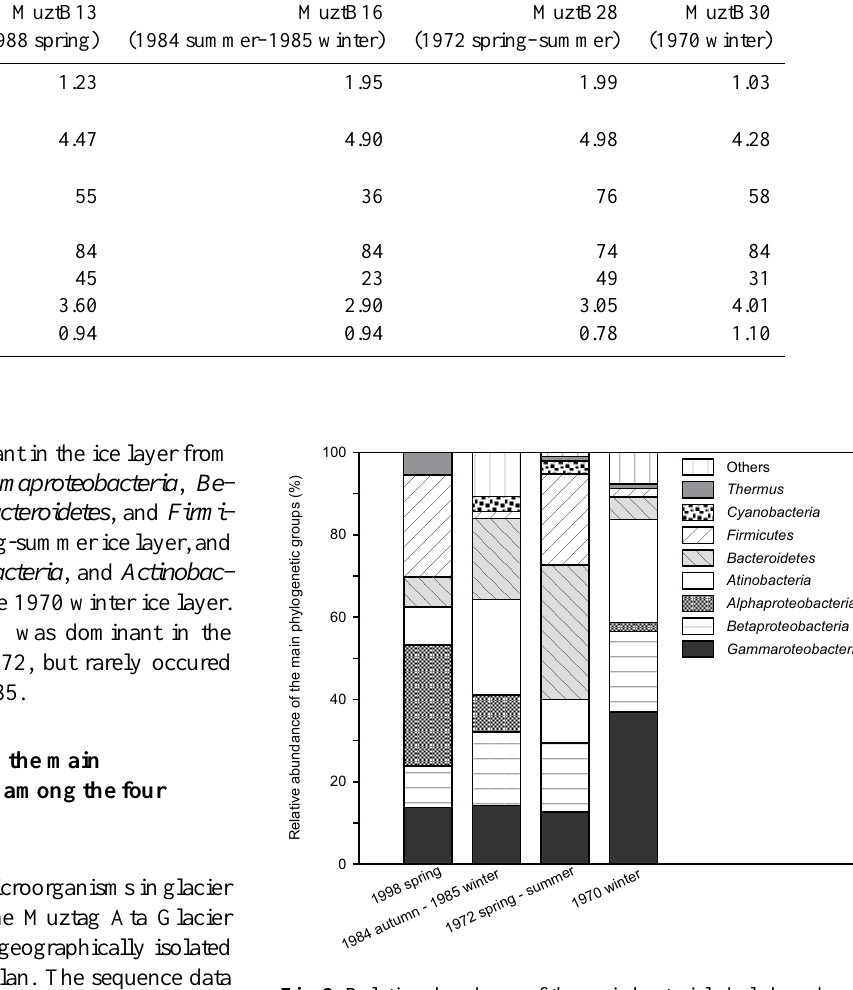
Table 1. Biomass and diversity of dominant bacteria in the Muztag Ata Glacier based on 16S rRNA gene sequence analysis. Biomass and diversity